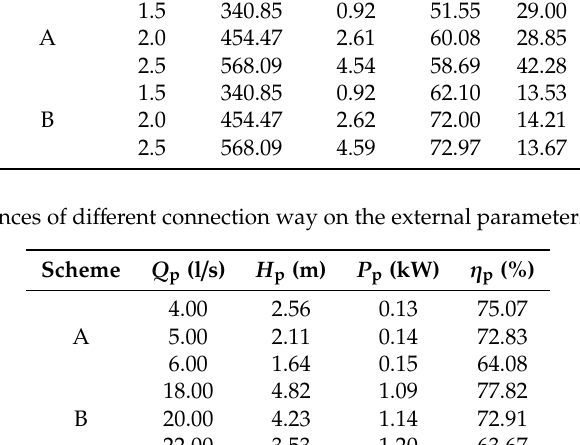
Table 1. Influences of different connection way on external parameters of the turbine.